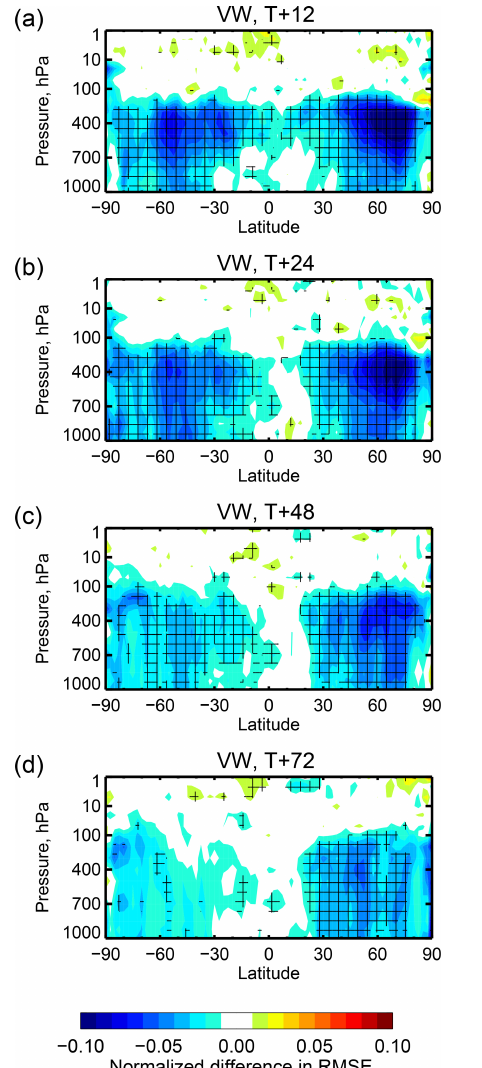
Figure 18. Change in vector wind RMSE due to assimilation of the seven IASI WV channels using the all-sky approach. Other details are the same as in Fig.